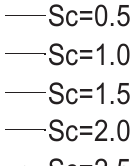
Figure 7. Concentration profiles for different Schmidt numbers at ξ = 1.0, n = 1.0, N = 1.0, γ = 2.01, ε = 0.45, f w = 0.0, κ = 0.5, and Nt = 1.0.